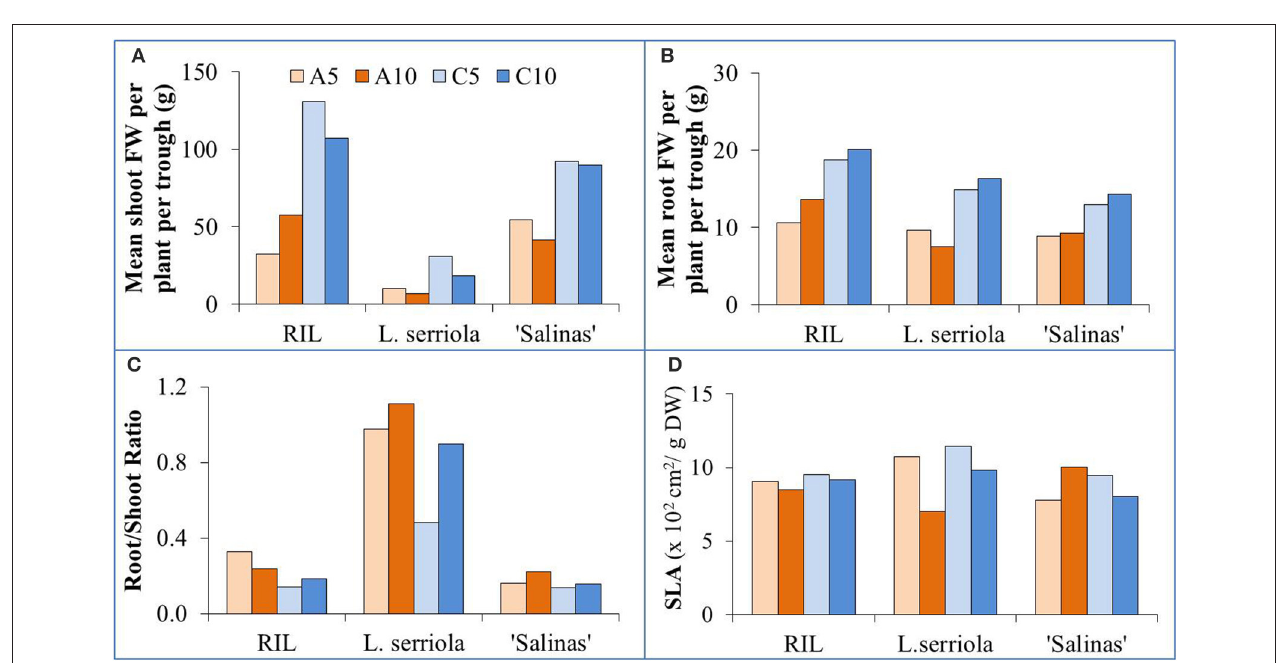
FIGURE 2 | Growth parameters of (A) mean shoot FW per plant per trough, (B) mean root FW per plant per trough, (C) root/ shoot ratio, and (D) SLA for the four experimental conditions (A5, A10, C5, and C10) for the 3 genotypes. Cumulative shoot and root FWs of all plants in each growing trough were measured and their FWs were normalized due to the different numbers of plants